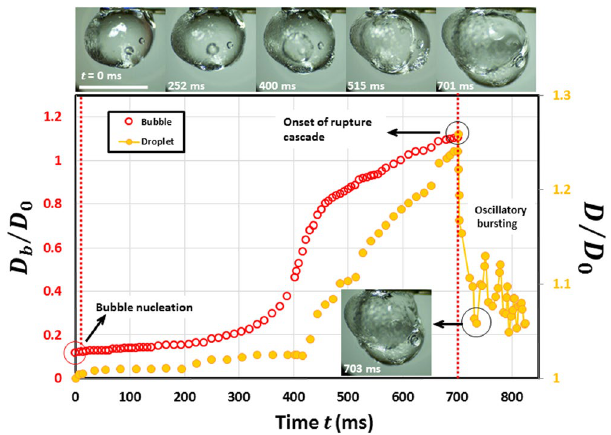
Figure 3. Temporal variation of non-dimensional bubble D D ( / ) stages of first oscillatory rupture cascade in a combusting ethanol gel droplet ( ~ D droplet image equals 2